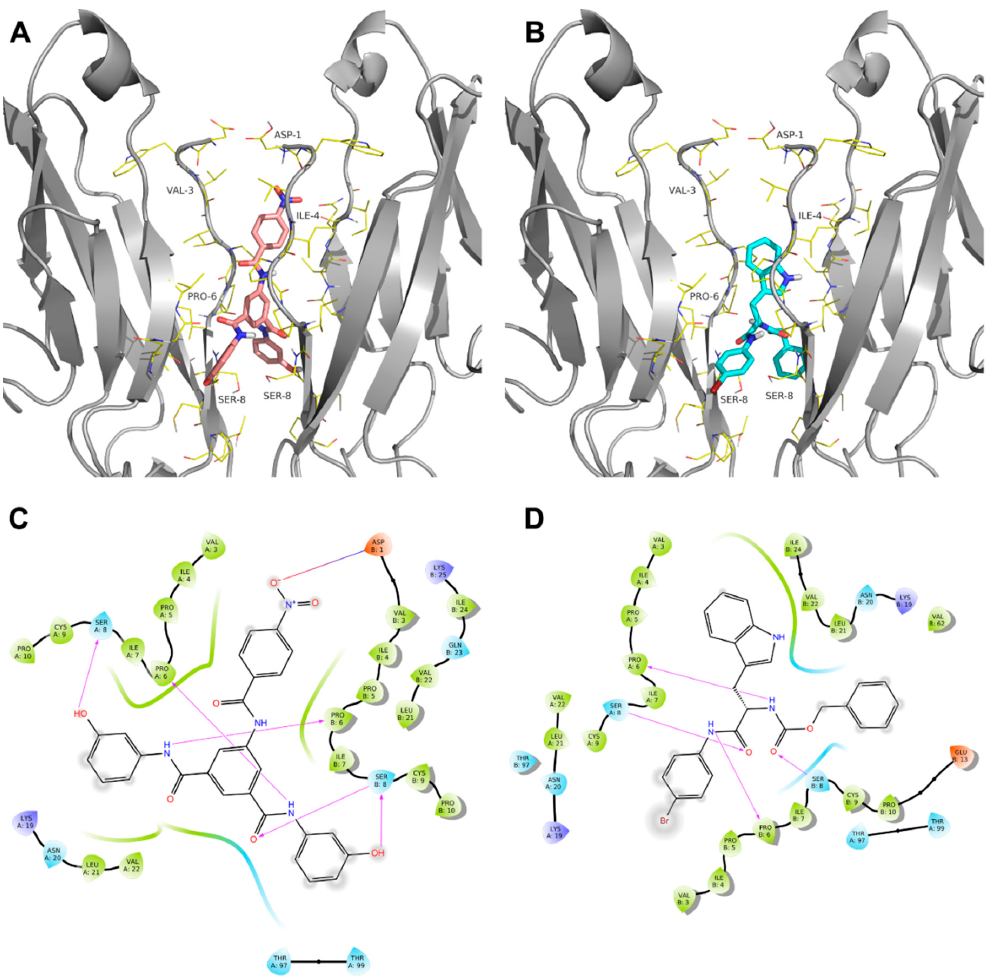
Figure 7. 3D representation of the theoretical binding mode for AS9 ( A ) and AS11 ( B ). 2D ligand interaction diagram of the theoretical binding mode for AS9 ( C ) and AS11 ( D ). Hydrogen bond interactions are shown as pink arrows. Positive and negative charged amino acids are represented in blue and red, respectively. Residues involved in hydrophobic or polar interactions are shown in green and light blue, respectively. Ligand-exposed fractions are indicated as a gray, circular shadow.